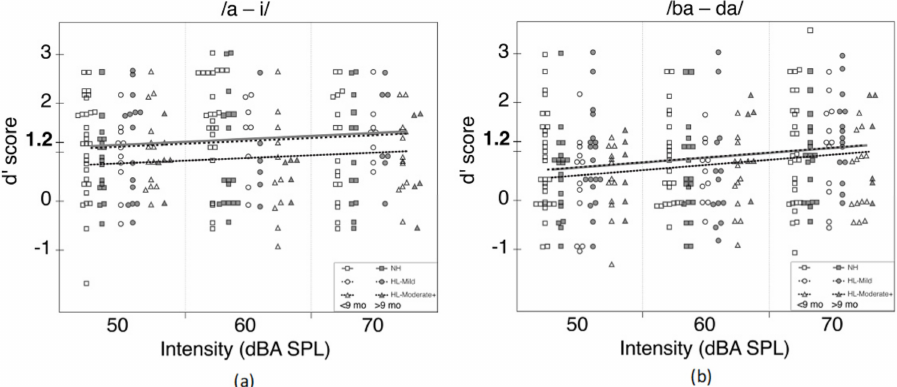
Figure 3. ( a ) Performance on /a-i/ as a function of intensity (50, 60, and 70 dBA SPL) represented in columnar format. Each intensity column contains d’ scores for each of three hearing groups: normal hearing (NH; squares), mild hearing loss (HL-mild; circles), and moderate+ hearing loss (HL-moderate+; triangles). Empty symbols represent participants with an age at test less than nine months and filled symbols represent participants with an age at test greater than nine months. Regression lines for each of the hearing groups as a function of intensity level are plotted across the intensity columns (thick grey line = NL; dashed line = HL-mild; dotted line = HL-moderate+). ( b ) Performance on /ba-da/ as a function of intensity (50, 60, and 70 dBA SPL) represented in columnar format. Each intensity column contains d’ scores for each of three hearing groups: normal hearing (NH; squares), mild hearing loss (HL-mild; circles), and moderate+ hearing loss (HL-moderate+; triangles). Empty symbols represent participants with an age at test less than nine months and filled symbols represent participants with an age at test greater than nine months. Regression lines for each of the hearing groups as a function of intensity level are plotted across the intensity columns (thick grey line = NL; dashed line = HL-mild; dotted line =